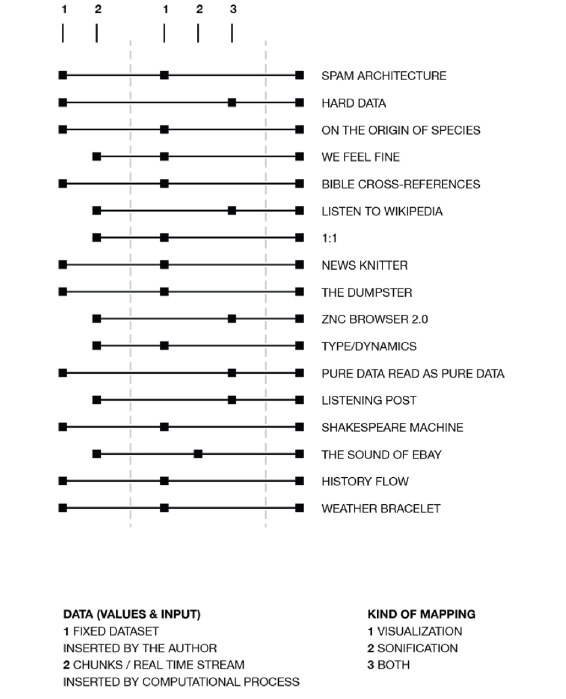
Figure 5 | Analysis graph: mechanics dimension – observation of artwork’s data and mapping processes.